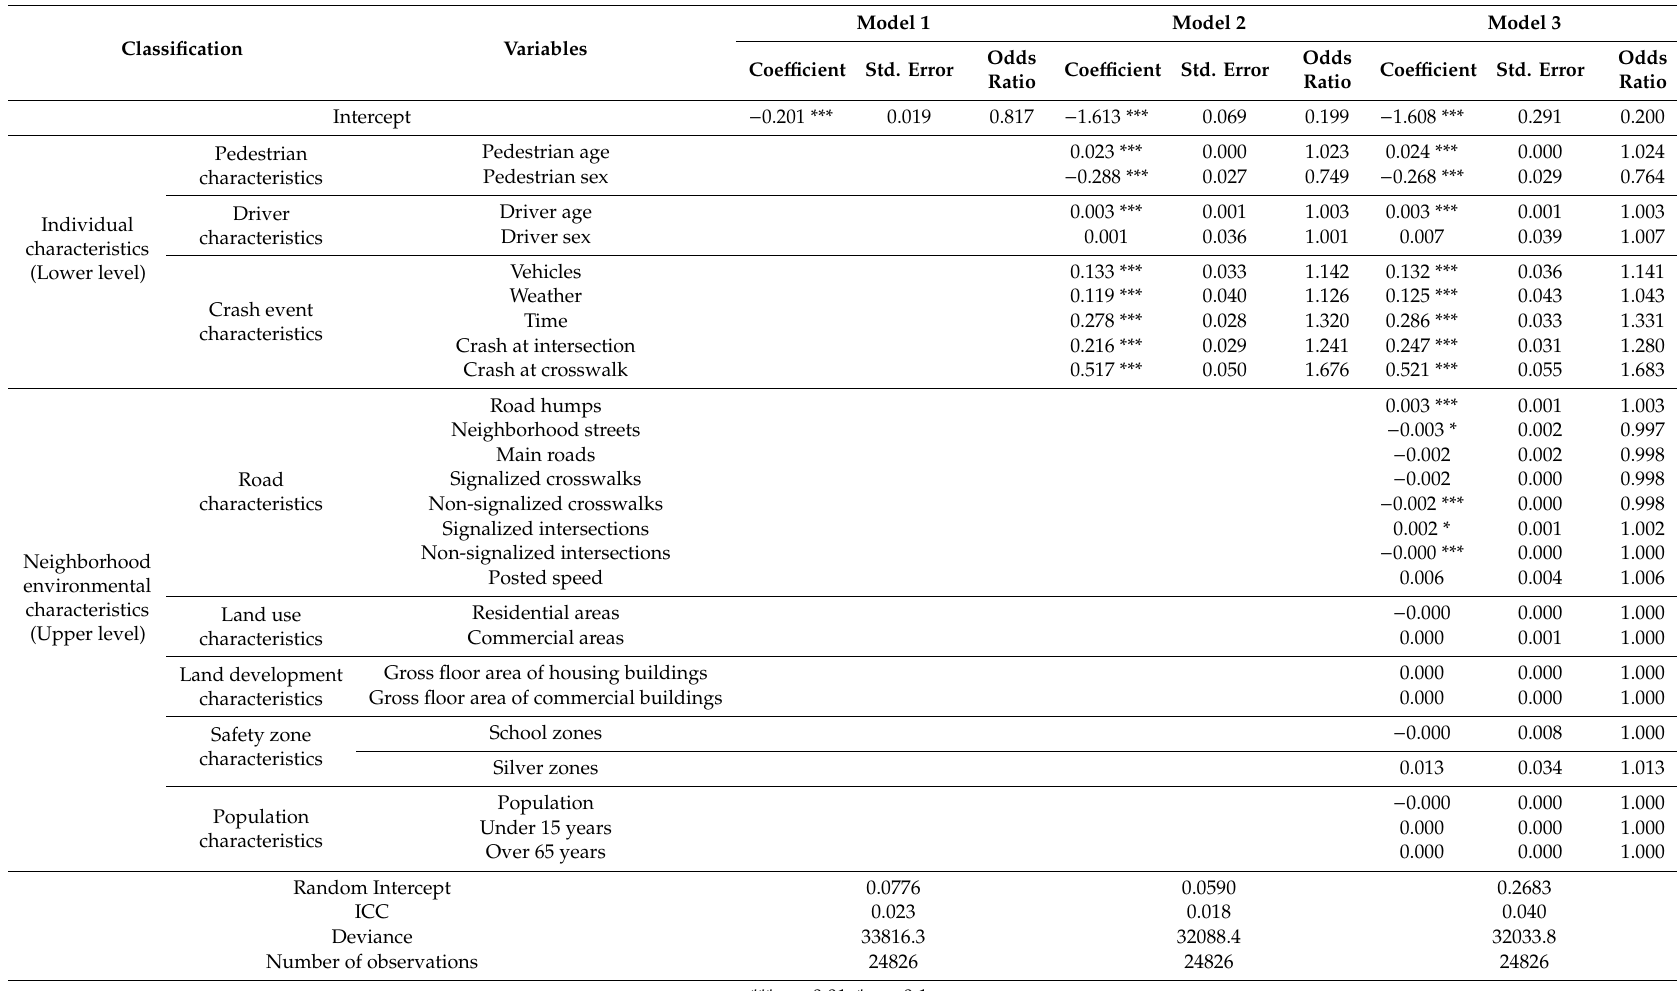
Table 2. Results of multilevel binomial logistic